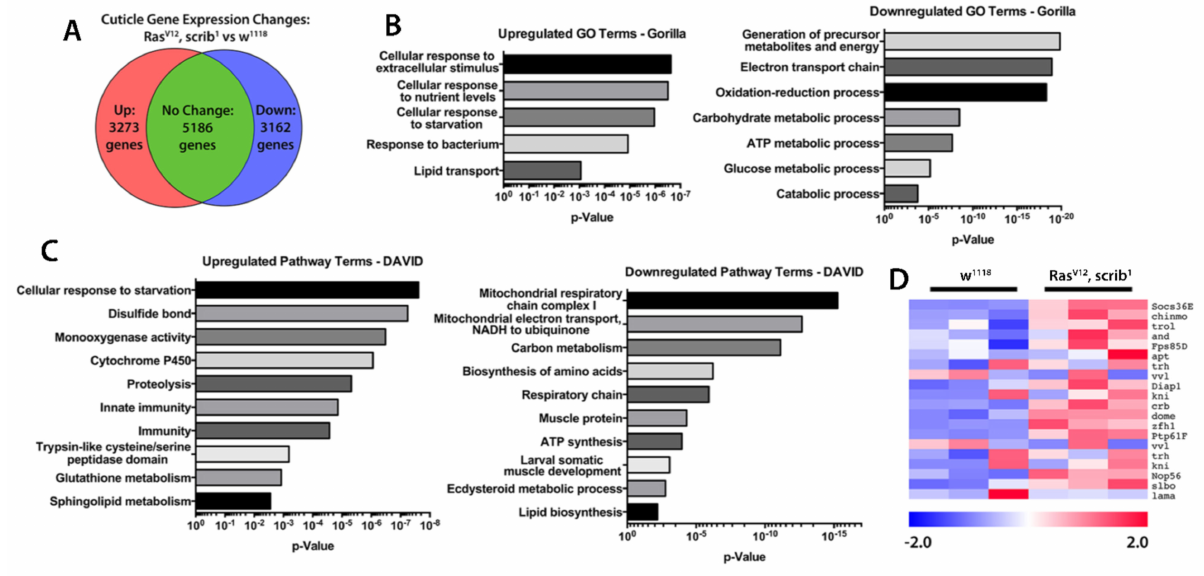
Figure 4. Molecular characterization of cachectic muscles from tumour bearing larvae. ( A ) Frequency of up- and down- regulated expression of genes identified in an RNAseq from cuticles and muscle of normal (w 1118 ) and MARCM Ras V12 , scrib 1 tumour-bearing animals. ( B ) List of GO terms enriched in up- and downregulated gene sets from RNAseq. ( C ) List of pathway terms enriched in up- and downregulated gene sets from RNAseq. ( D ) Heatmap of relative expression levels of JAK/STAT pathway genes from RNAseq. Heatmap colour intensity displays log 2 -fold change values relative to the mean gene expression level across both